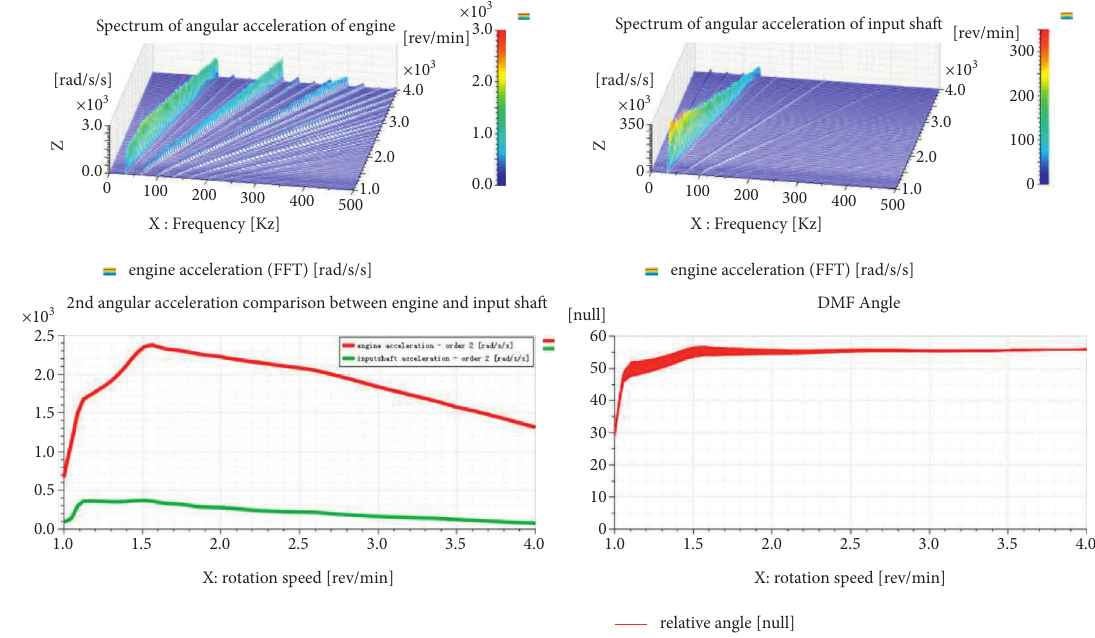
Figure 9: Angular acceleration frequency spectra.